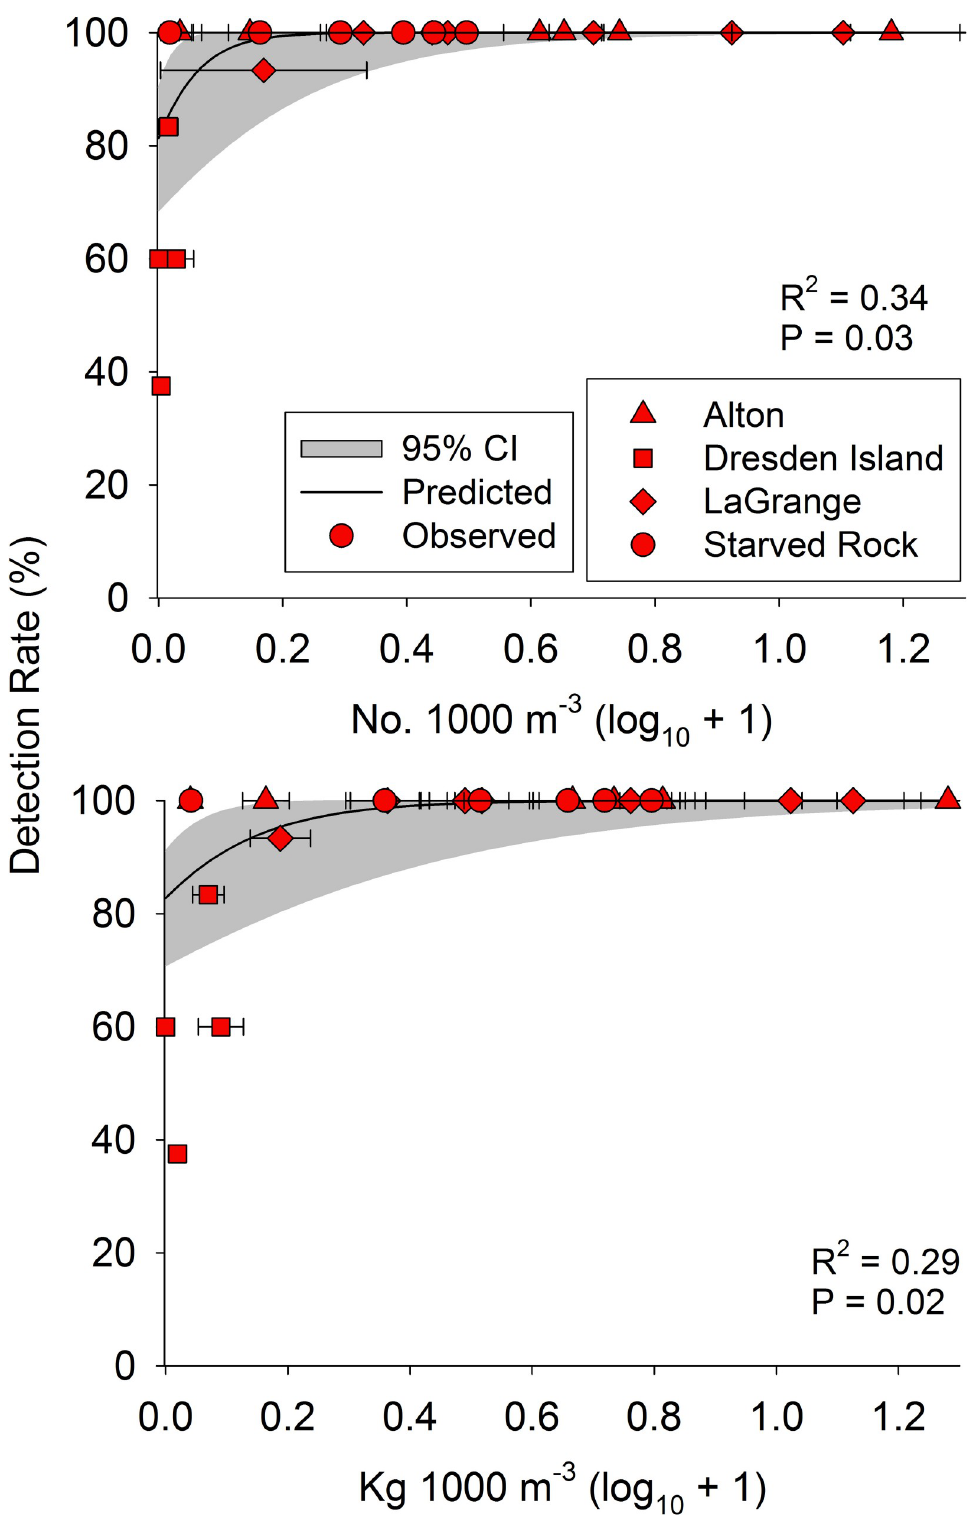
Fig 5. Relationships between site mean (standard error) Silver Carp density and percent of samples with detectable eDNA concentrations (Detection Rate; SC-TM4 marker; R 2 : McFadden’s R 2 ) collected from the Illinois River, USA. Symbols represent river reach (see Fig 1) and error bars reflect variability among samples at a